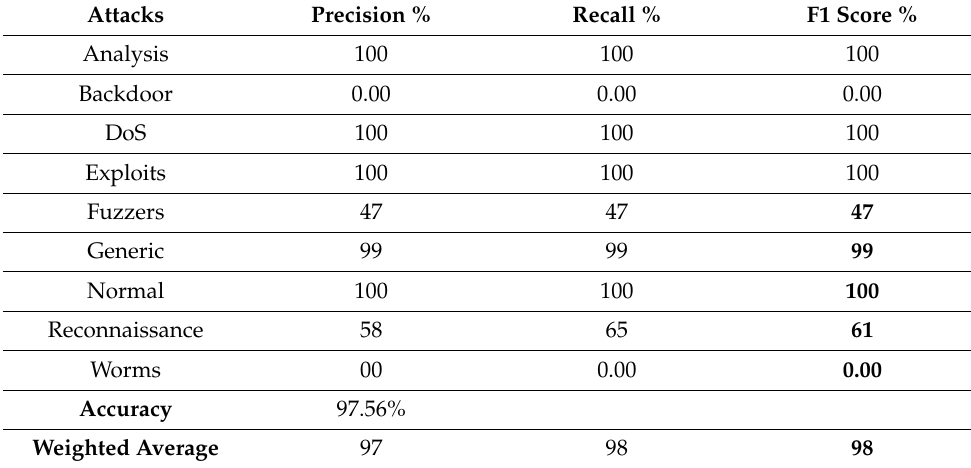
Table 5. Results of SVM on